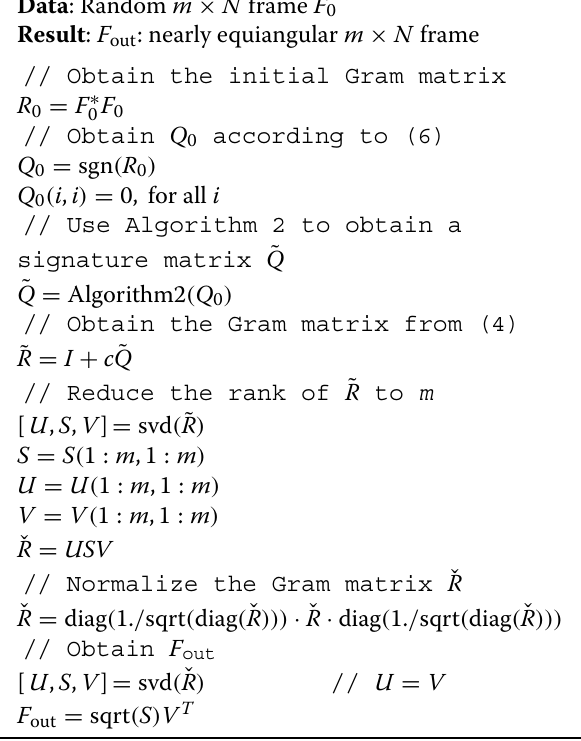
Algorithm 2 is a modified alternating projections Algorithm 3: Construction of a nearly